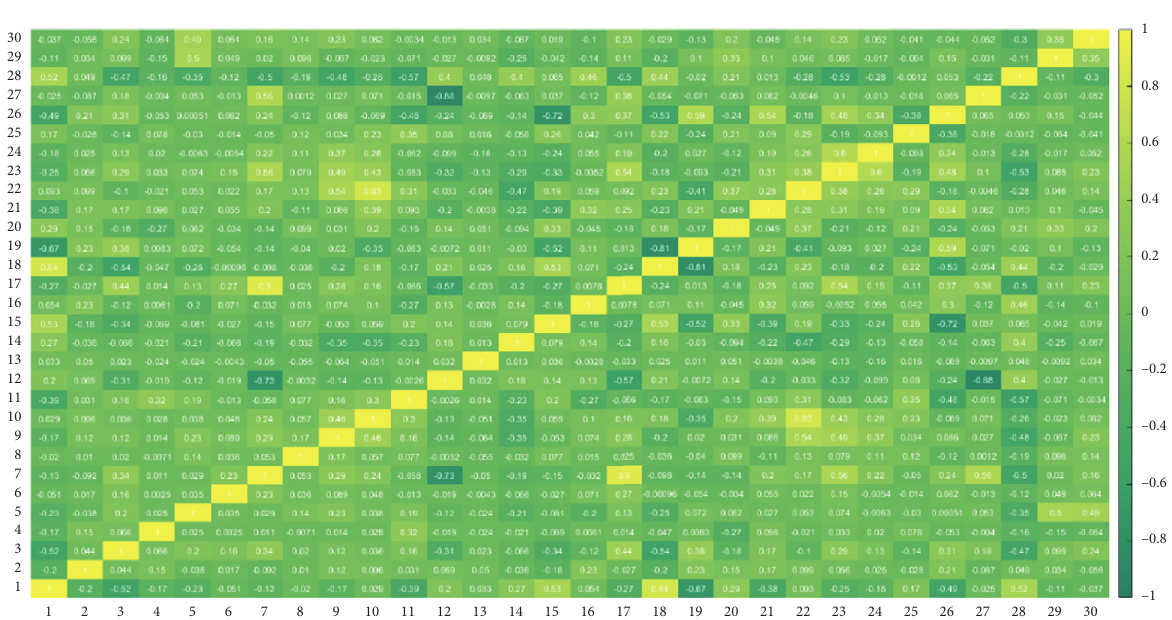
Figure 2: Main variables correlation coefficient thermodynamic diagram before deletion.